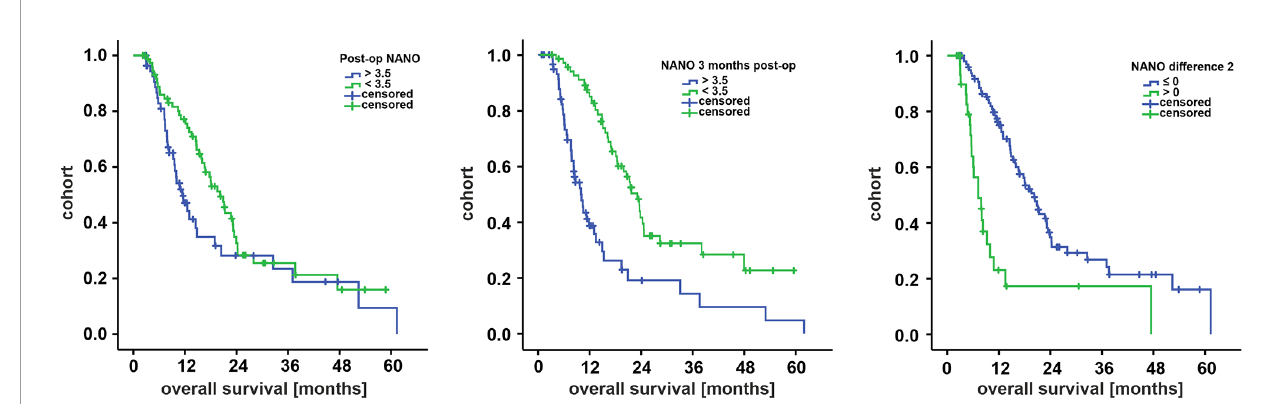
FIGURE 1 | Survival curves for subcohorts by Kaplan – Meier analysis for postoperative NANO scale (left), NANO scale at 3 months follow-up (middle), and NANO scale difference of postoperative values and values at 3 months follow-up (right). Cutoffs for the fi rst two diagrams were determined via ROC analysis. NANO difference 2 was dichotomized in stable/increased ( ≤ 0) or worsened (>0) neurological performance at 3 months follow-up compared with postoperative values. NANO, Neurologic Assessment in